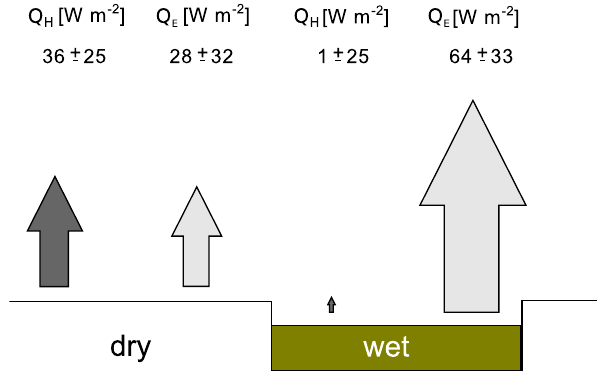
Fig. 9. Sensible Q H and latent heat fluxes Q E at wet and dry surfaces during summer 2008. The values are estimated from the eddy covariance measurements of the stationary and mobile eddy covariance systems. The areas of the arrows are scaled according to the heat flux values. 5